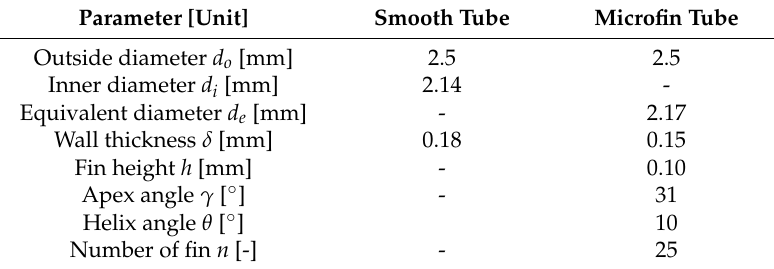
Figure 3. Photography and schematic view of the test tube: ( a ) smooth tube; ( b ) microfin tube; and ( c ) schematic view of the microfin tube. Table 1. Specifications of the test tubes.